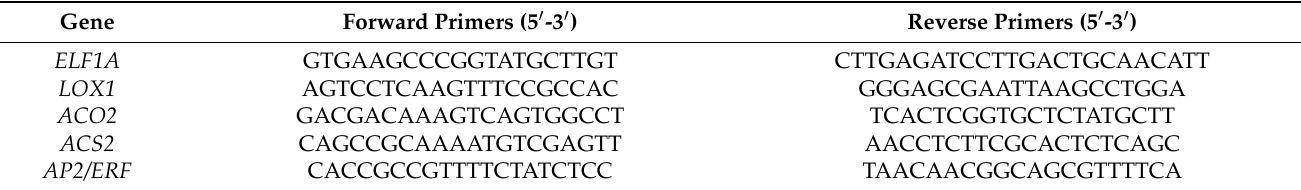
Table 1. RT-qPCR genes and specific